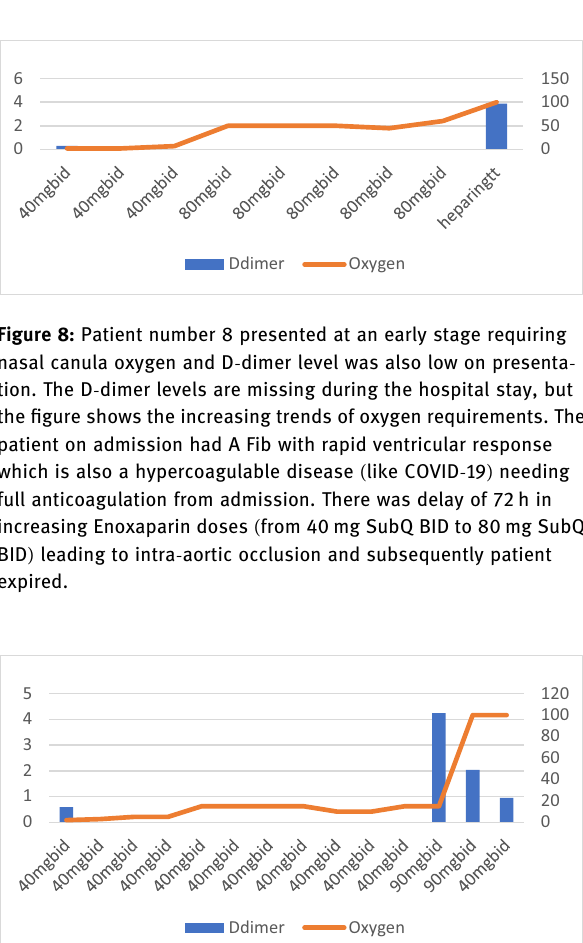
Figure 7: Patient number 7 presented at an early stage requiring oxy mask and D - dimer level was also low on presentation. The fi gure demonstrates that D - dimer trends slightly increase or decrease, but the increasing requirements remained almost same as patient was possibly getting high oxygen via oxy mask. This patient was treated with intermediate dose of Enoxaparin ( 40 mg SubQ BID ) . moved from the hospital fl oor to the ICU have a higher chance of recovery compared to those who did not receive any anticoagulation prior to their critical care unit admis - sion. The reason behind these failures is that anticoagula - tion does not dissolve microthrombi ( blood clots ) , rather prevents their further growth. Treating patients with antic - oagulation only can bene fi t when capillaries are still open ( not clogged due to microthrombi ) . Bottom line is that patients presenting to hospital for need of nasal cannula oxygen or high fl ow nasal cannula oxygen and/or patient with low D - dimer, usually survive with anticoagulation and steroid combination treatments.